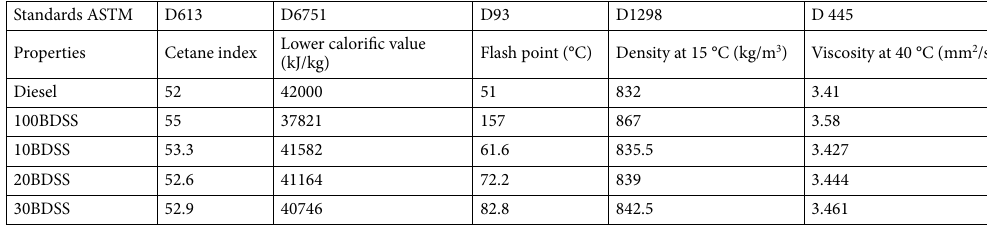
Table 1. Blending fuel